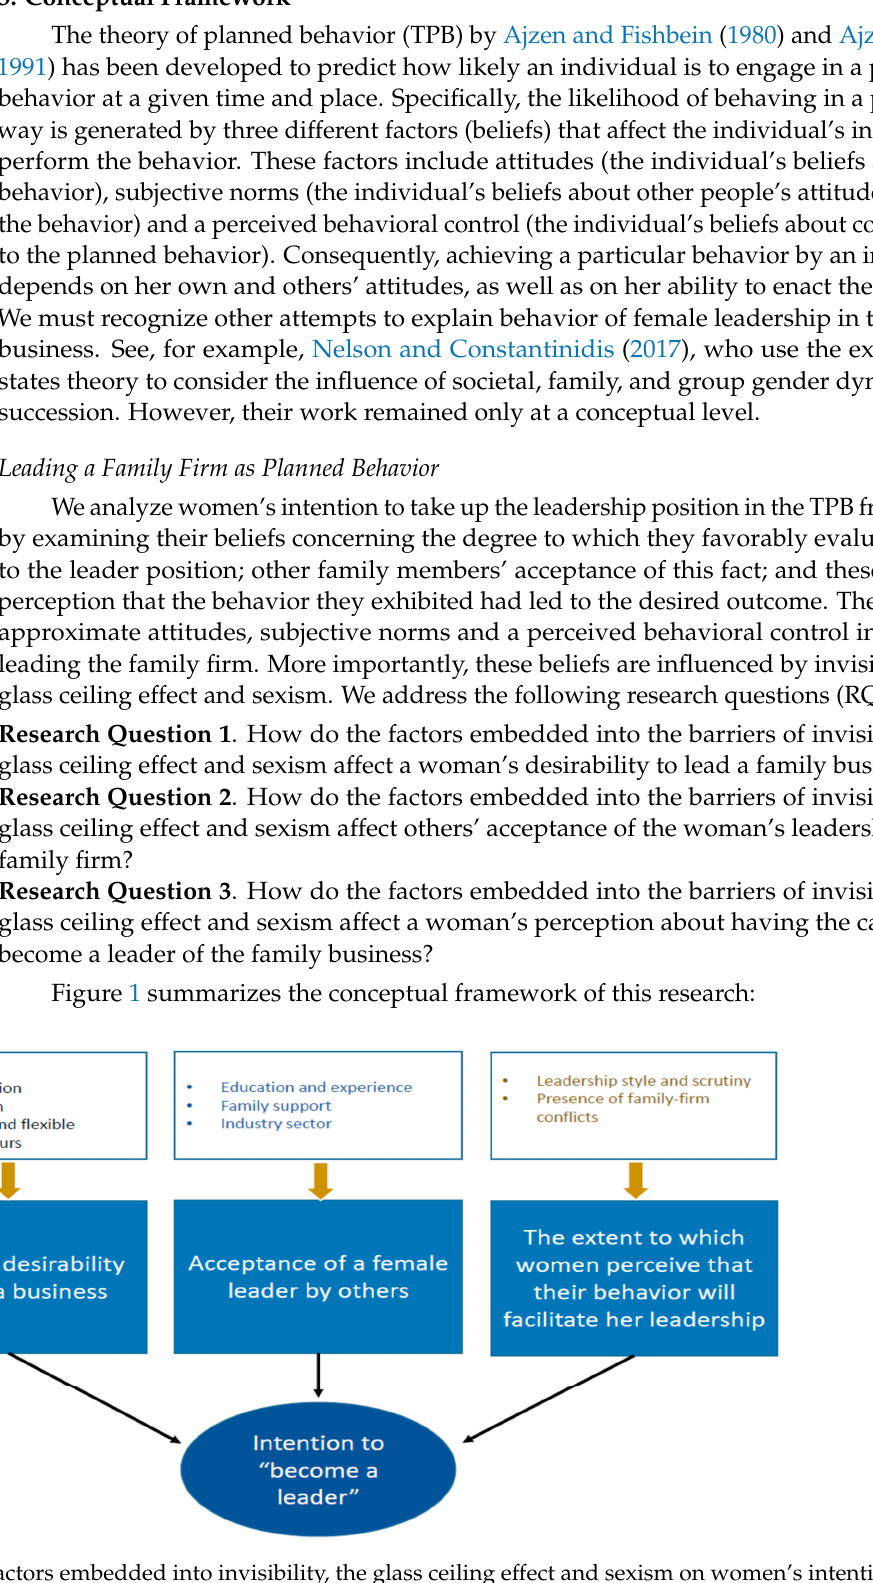
Figure 1. The influence of factors embedded into invisibility, the glass ceiling effect and sexism on women’s intention to lead the family business in the theory of planned behavior model (Source: Authors).